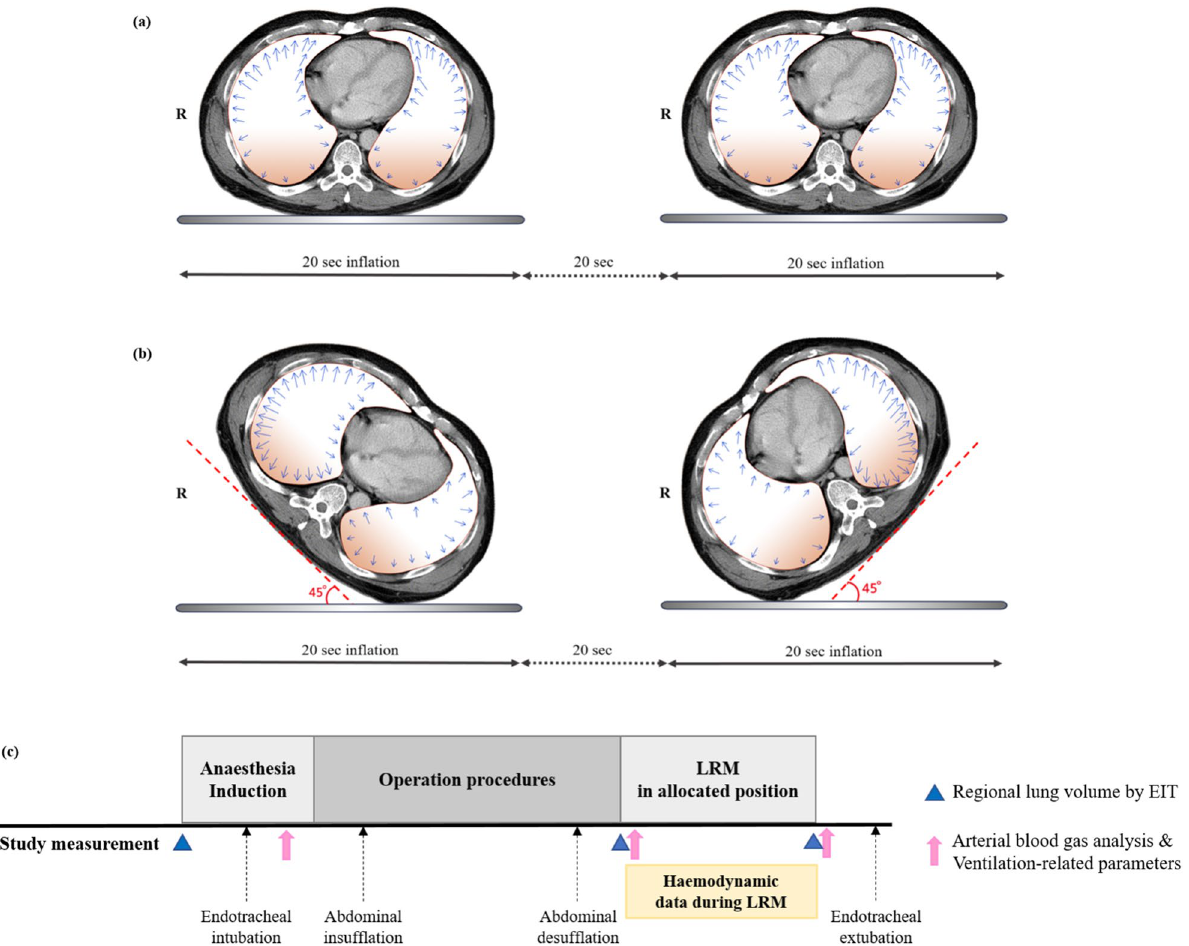
Figure 1. Lung recruitment maneuver in ( a ) supine position and ( b ) semi-lateral position ( L eft lateral decubitus position and right lateral decubitus position). The dark color gradation inside the lung refers to the dependent portion of the lung during surgery, where atelectasis often occurs. In addition, the blue arrows refer to the hypothetical regional distribution of lung volume during lung recruitment maneuver. ( c ) Study